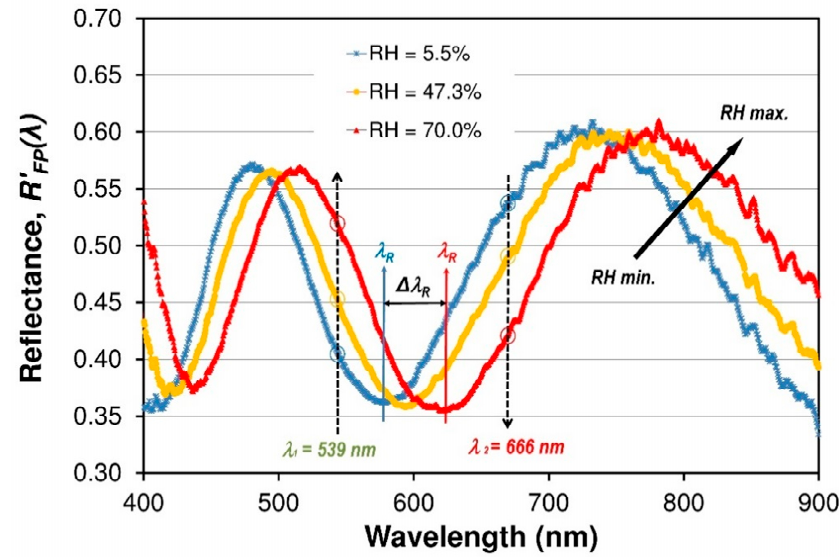
Figure 9. Normalized spectral reflectance signals ( R FP ’( λ )) of the FPI sensor at three operating RH of the air at RT (22 ◦ C). Device presents a non-linear tuning fringe pattern for RH variation between 5.5% and 70%.